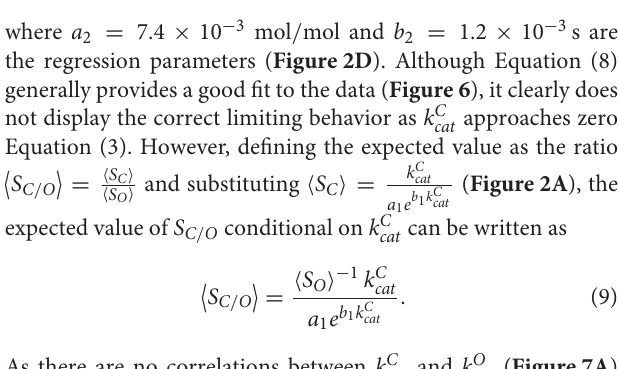
FIGURE 3 | Normal Q-Q standardized plots of residuals for log ( Figure 2D ).